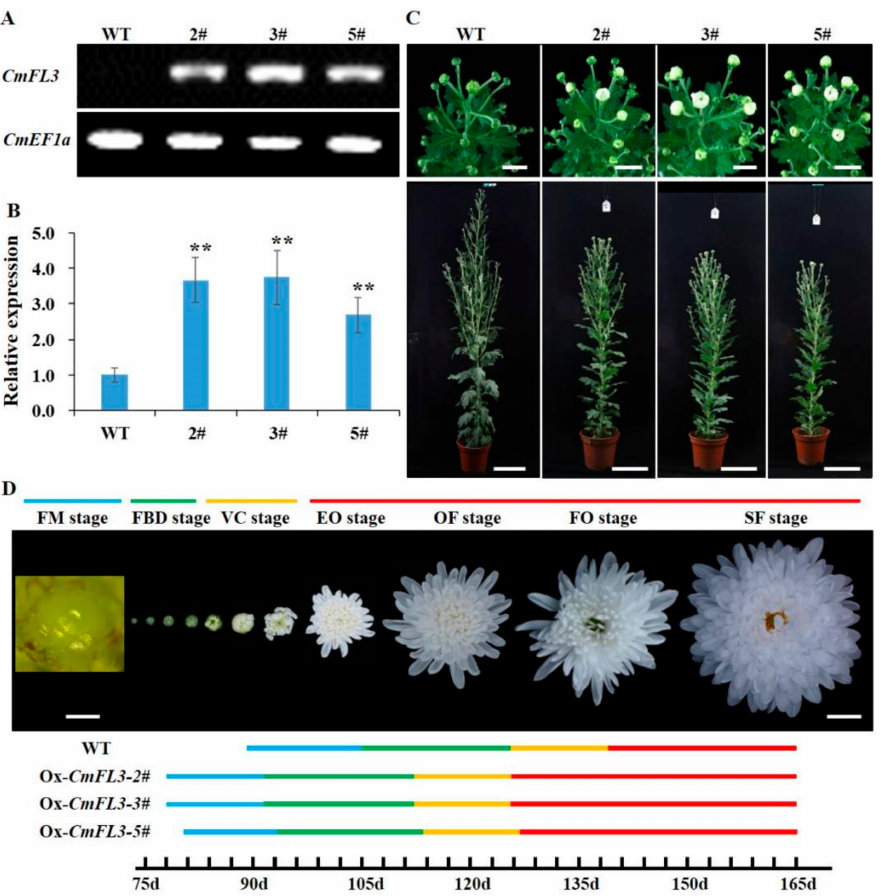
Figure 5. Phenotypes of CmFL3 transgenic ‘Jinba’ plants. ( A ) RT-PCR analysis of CmFL3 in WT plants and Ox lines at the cDNA level; the forward primer was from pMDC-43 vector and reverse primer from the CDS. ( B ) The relative expression levels of CmFL3 in the WT and Ox transgenic plants were determined using qRT-PCR. CmEF1a was the control gene. The values represent means ± SE ( n = 3). Significant differences were determined using Student’s t -test (** p < 0.01). Each sample included three biological and three technical replicates. ( C ) Flowering phenotype of WT and Ox transgenic lines. The photographs were captured at 116 d after transplantation. ( D ) Development of inflorescence in WT ‘Jinba’ and Ox plants. FM stage, flower meristem stage; FBD stage, flower bud development stage; VC stage, visible color stage; EO stage, early opening stage; OF stage, opened flower stage; FO, fully opened flower stage; SF stage, senescing flower stage. Bars = 3.0 cm in the upper panel, whereas bars = 13.5 cm in the lower panel. Bar = 3 cm in ( D ) except for the FM stage, where bar = 500 µ